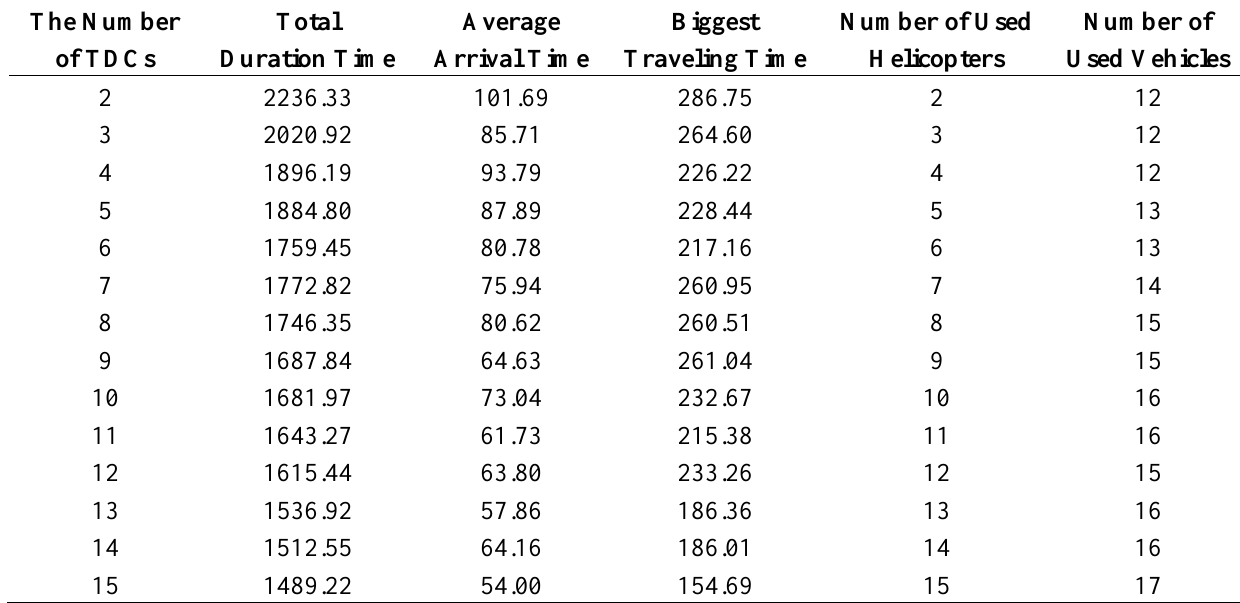
Table 3. Results with different numbers of TDCs ( Q = 5000).